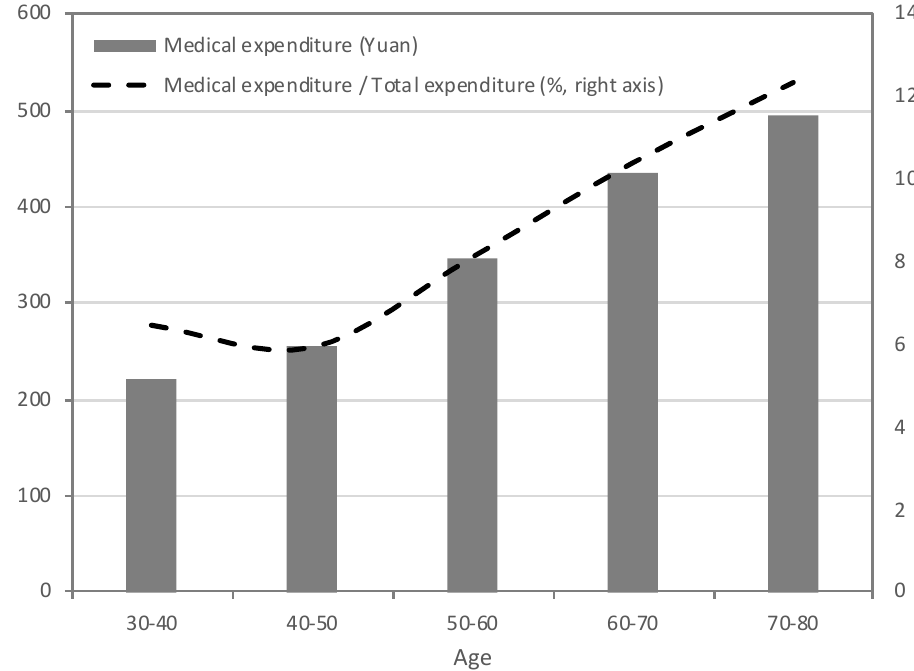
Figure 2. Medical Expenditure over the Lifecycle (2003 to 2007).